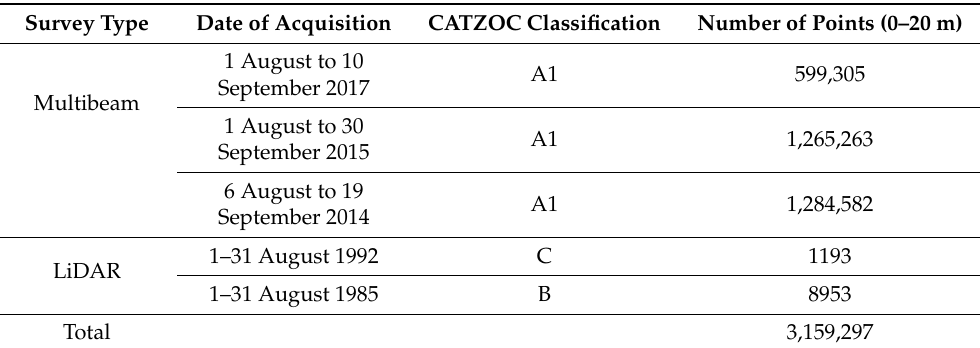
Table 1. CHS hydrographic surveys used within this study.